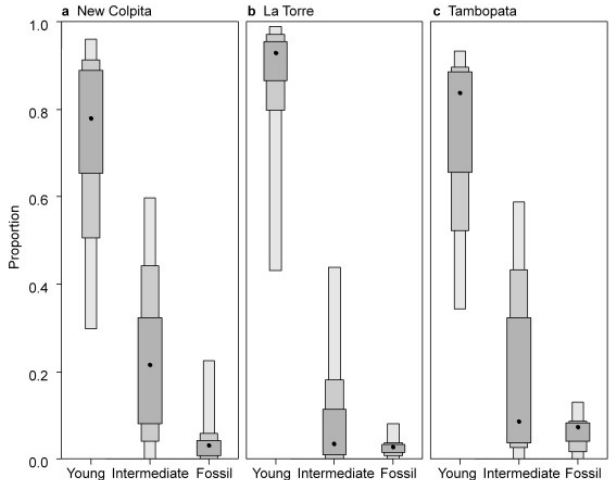
Figure 2. Potential contributions of different carbon age groups in the three drainage (a–c) systems with old carbon. The intermediate- aged class includes carbon dated to 200–2000yrBP that could be derived from soil organic matter, black carbon or cutting of the river sediment packs. The black dot represents the most likely solution. The dark, light and lightest grey boxes represent, respectively, the 50, 75 and 95% confidence intervals of the estimates. All samples contained some aged C, but that from La Torre contained the least amount (b) .